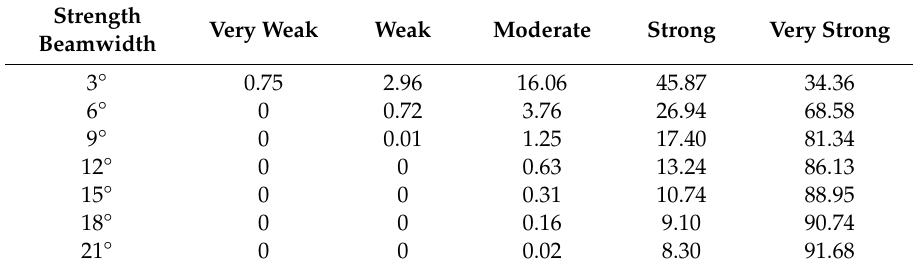
Figure 10. The distributions of correlation coefficients between Tomoradar waveforms and simulated- waveforms for 8565 Tomoradar measurements. The correlation coefficients are displayed with a range from 0 to 1 and an interval of 0.2 based on the correlation strength. The correlation strengths are expressed with the colors of red, green, yellow, cyan, and blue from very weak to very strong. Table 1. The percentiles of Tomoradar measurement numbers classified by the correlation strength.